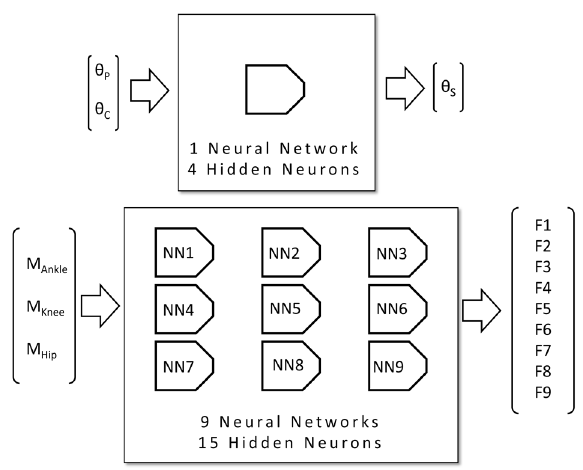
Figure 4. Complete neural system for the inverse